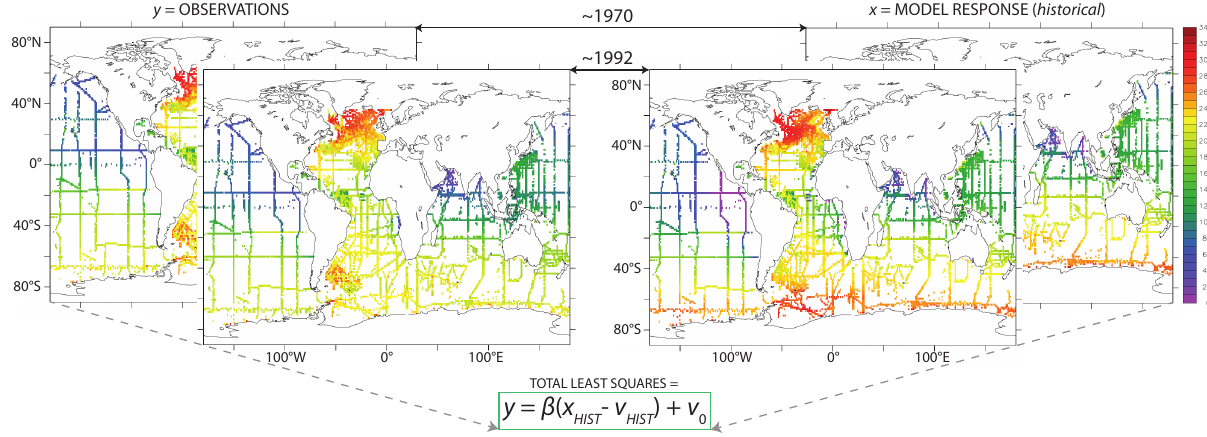
Fig. 1. Schematic summary of the optimal detection method used here. The left panels show the observed distribution of dissolved oxygen data ( y ; µmolkg − 1 ) for ∼ 1970 and ∼ 1992, averaged between 100–3000m. The right panels show the masked and re-mapped ensemble mean model output ( x HIST ) from historical simulations of ESMs (MPI-ESM-LR or HadGEM2-ES) averaged between 100–3000m. y and x HIST are then provided to the Total Least Squares regression as zonal mean [O 2 ] differences between the two time periods, where v HIST and v 0 are estimates of the noise in the model response and observations,